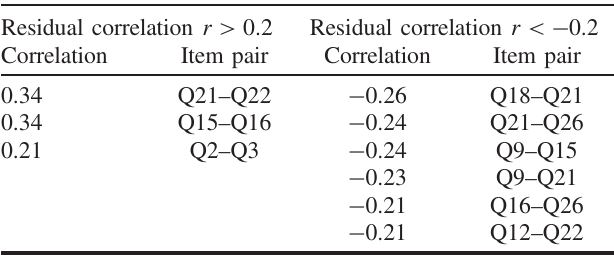
TABLE II. BEMA item pairs with residual correlations j r j > 0 . 2 . Residual correlation r > 0 .